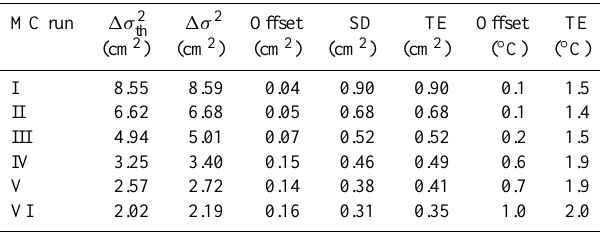
Table 3. The mean values and deviation from theory and SD for the differential diffusion lengths of the Monte Carlo runs obtained with the correlation method for 5cm samples. Measurement uncertain- ties of 0.06 for δ 18 O and 0.40 for δ 2 H are used. Column 6 and 8 give the total error in the squared differential diffusion length and in the resulting firn temperature,